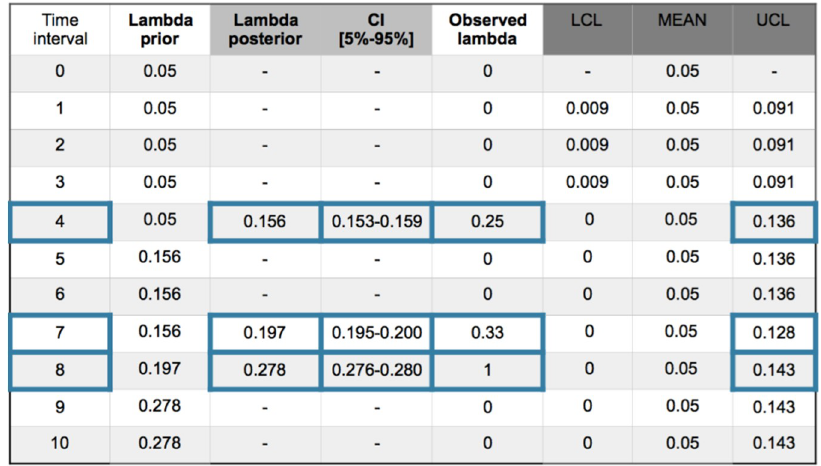
Figure 17. Exponential–gamma model. Recurrent with mean prior method. Evolution of collected (ic’s) and safety barrier fails in 10 intervals. Confidence interval (CI) [5%–95%]. Out of limits framed blue.